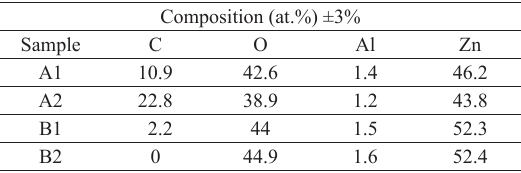
Table 3. EDS area measurements over an area of 1 mm x 1mm of the AZO/PET films. From Figure 4, the C concentration represents an estimate of the density of cracks along the AZO film.